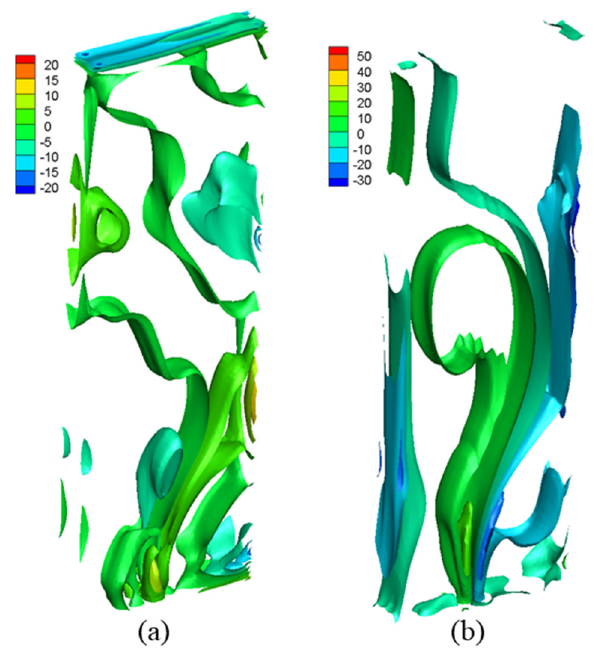
Figure 6. Distribution of various vortices of different magnitudes in the column: ( a ) X-component, ( b ) Z-component.